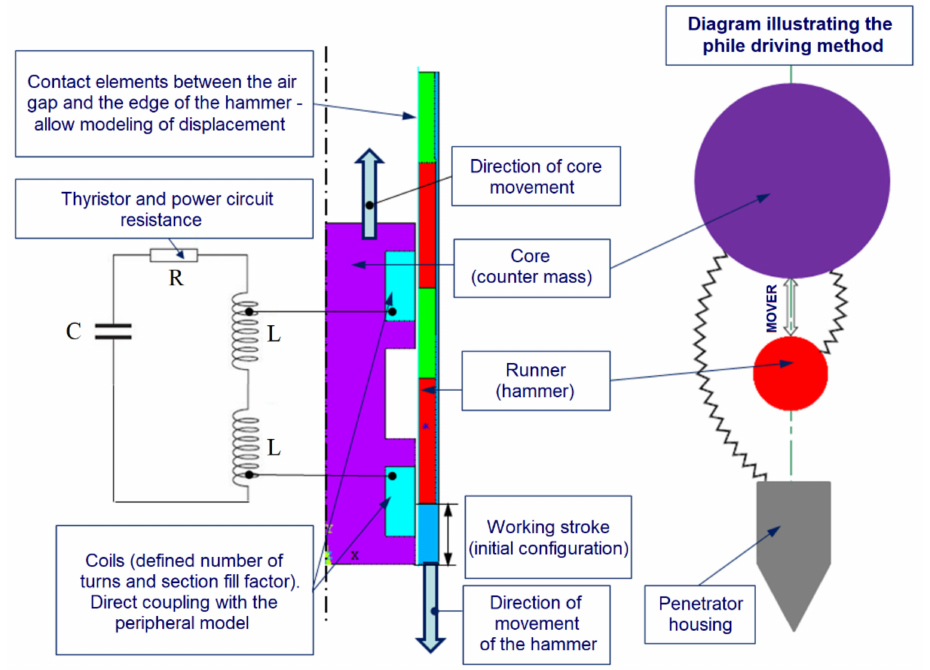
Figure 11. The principle of the numerical model